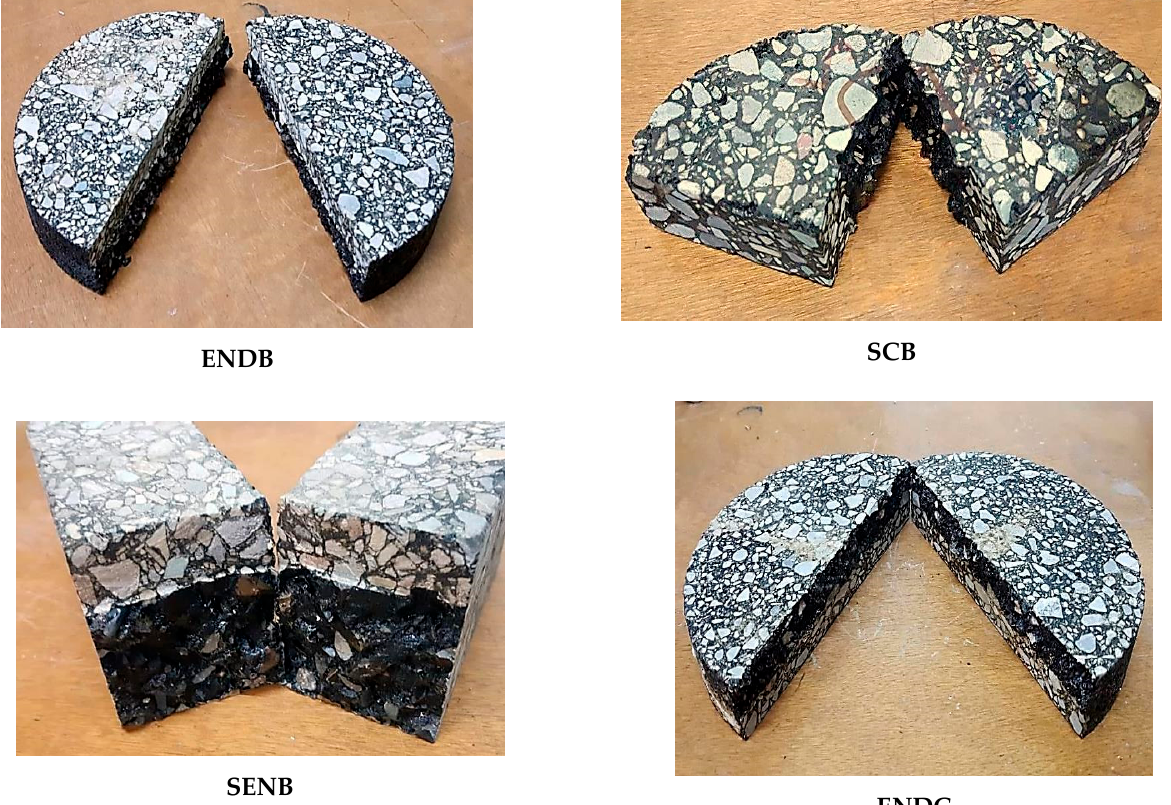
Figure 7. Fracture trajectory and fracture surfaces observed for the tested ENDB, SCB, SENB and ENDC specimens.